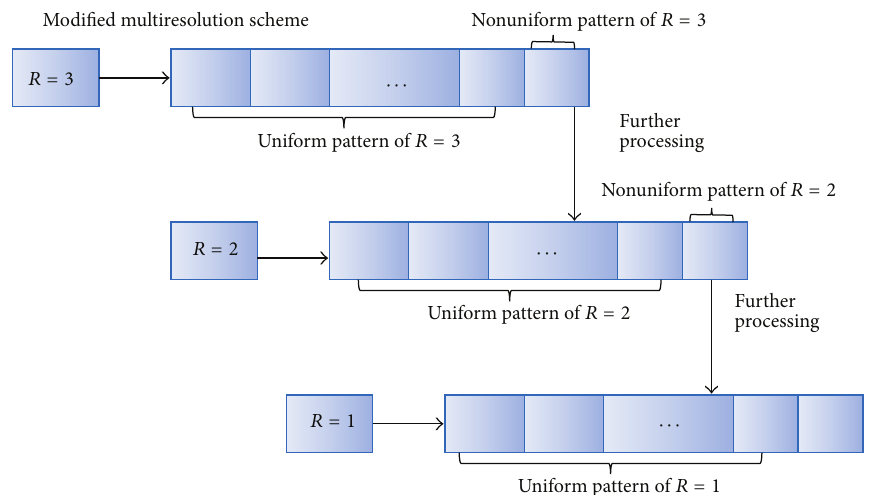
Figure 4: An illustration of proposed hierarchical multiresolution system.